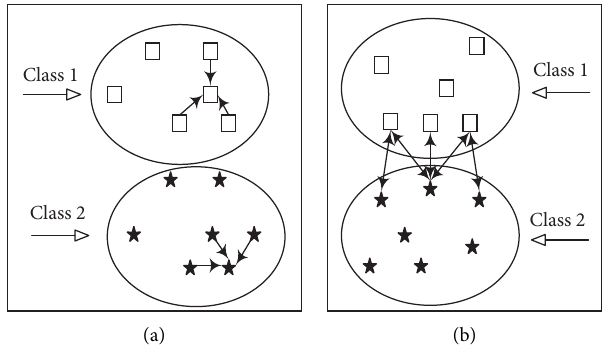
Figure 2: The adjacency relationship of the intrinsic graph and the penalty graph of the marginal Fisher analysis ( k 1 � k 2 � 3): (a) intrinsic graph; (b) penalty